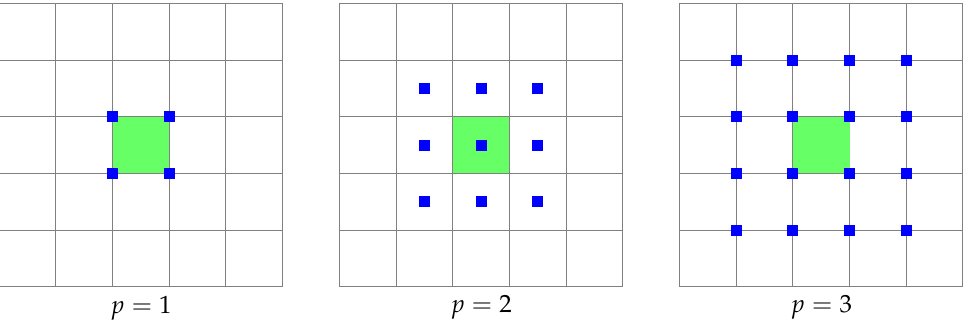
Figure 2. Number of control points for a given element on a simple B-Spline surface with different polynomial degrees. The element is highlighted and the blue squares represent control